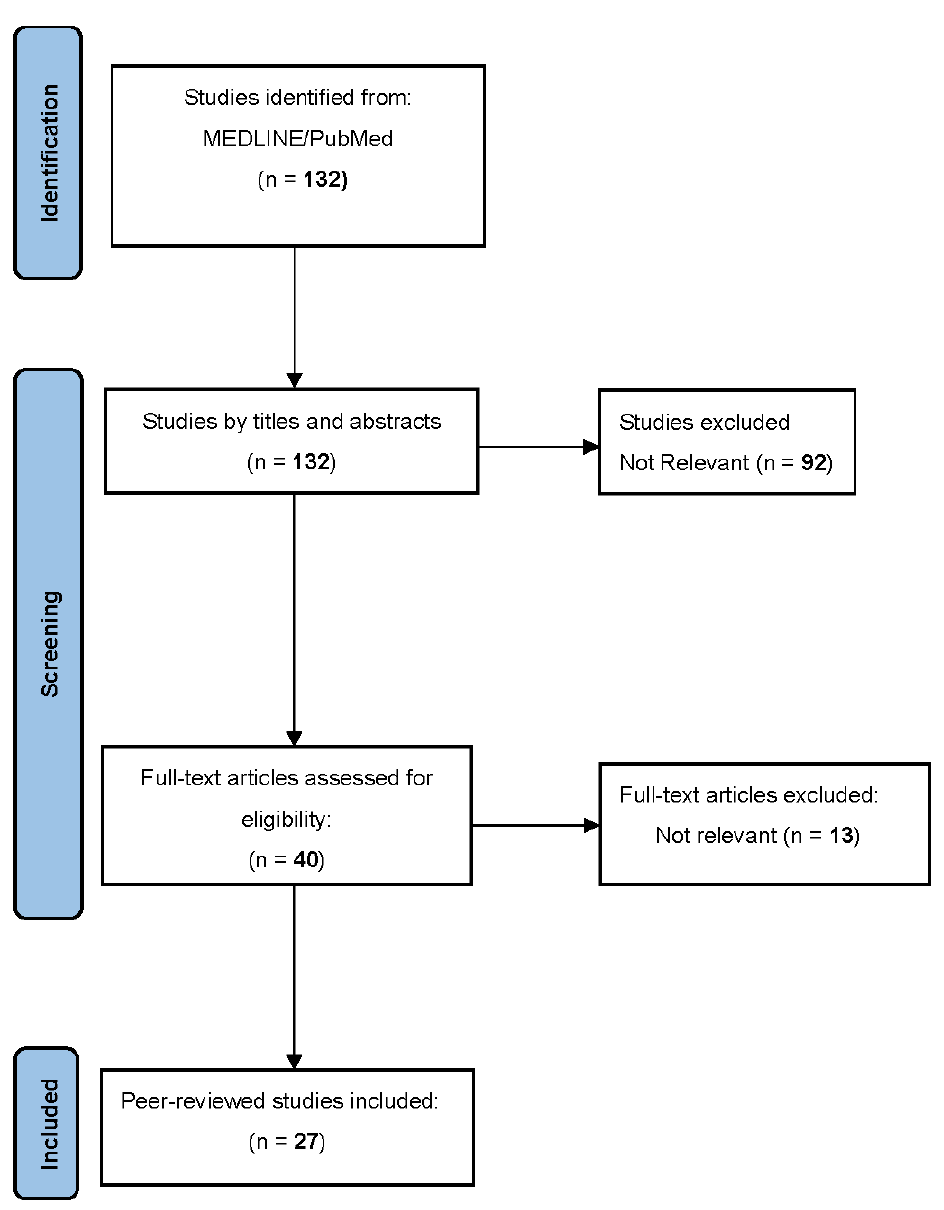
Figure 1. PRISMA flow diagram of study search and selection.